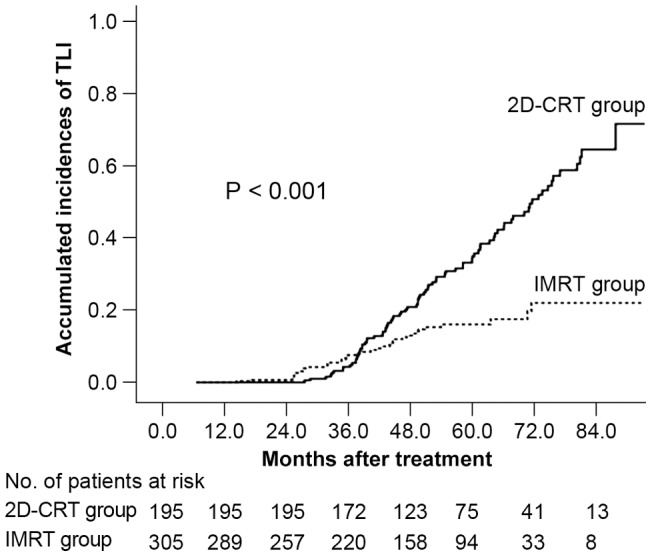
Kaplan-Meier curve of temporal lobe necrosis probability.Comparison of patients treated with intensity-modulated radiotherapy (IMRT) or conventional two-dimensional radiotherapy (2D-CRT).